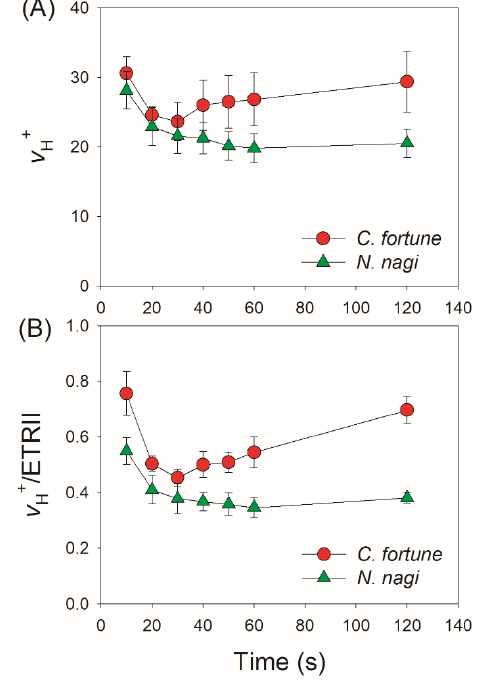
Figure 6. Changes in the relative proton flux through the thylakoid membrane ( v H+ ) ( A ) and relative CEF ( B ) after transition from transition from 59 to 1809 µ mol photons m − 2 s − 1 in leaves of Cyrtomium fortune and Nageia nagi . The relative CEF was estimated by the v H+ /ETRII ratio. The data are the means ± SE (n = 5).